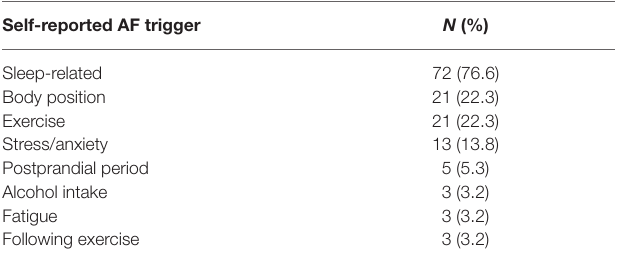
TABLE 1 | Self-reported triggering situations of atrial fibrillation (AF) symptoms.